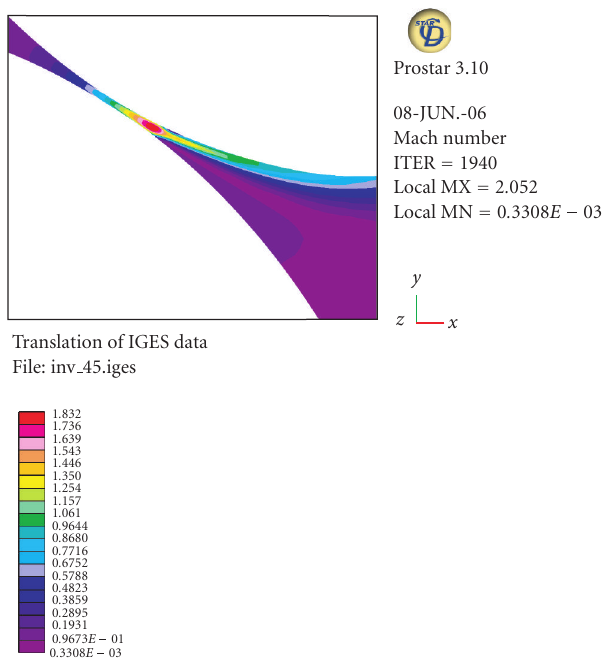
Figure 9: Mach number contours in rotor-rotor gap.